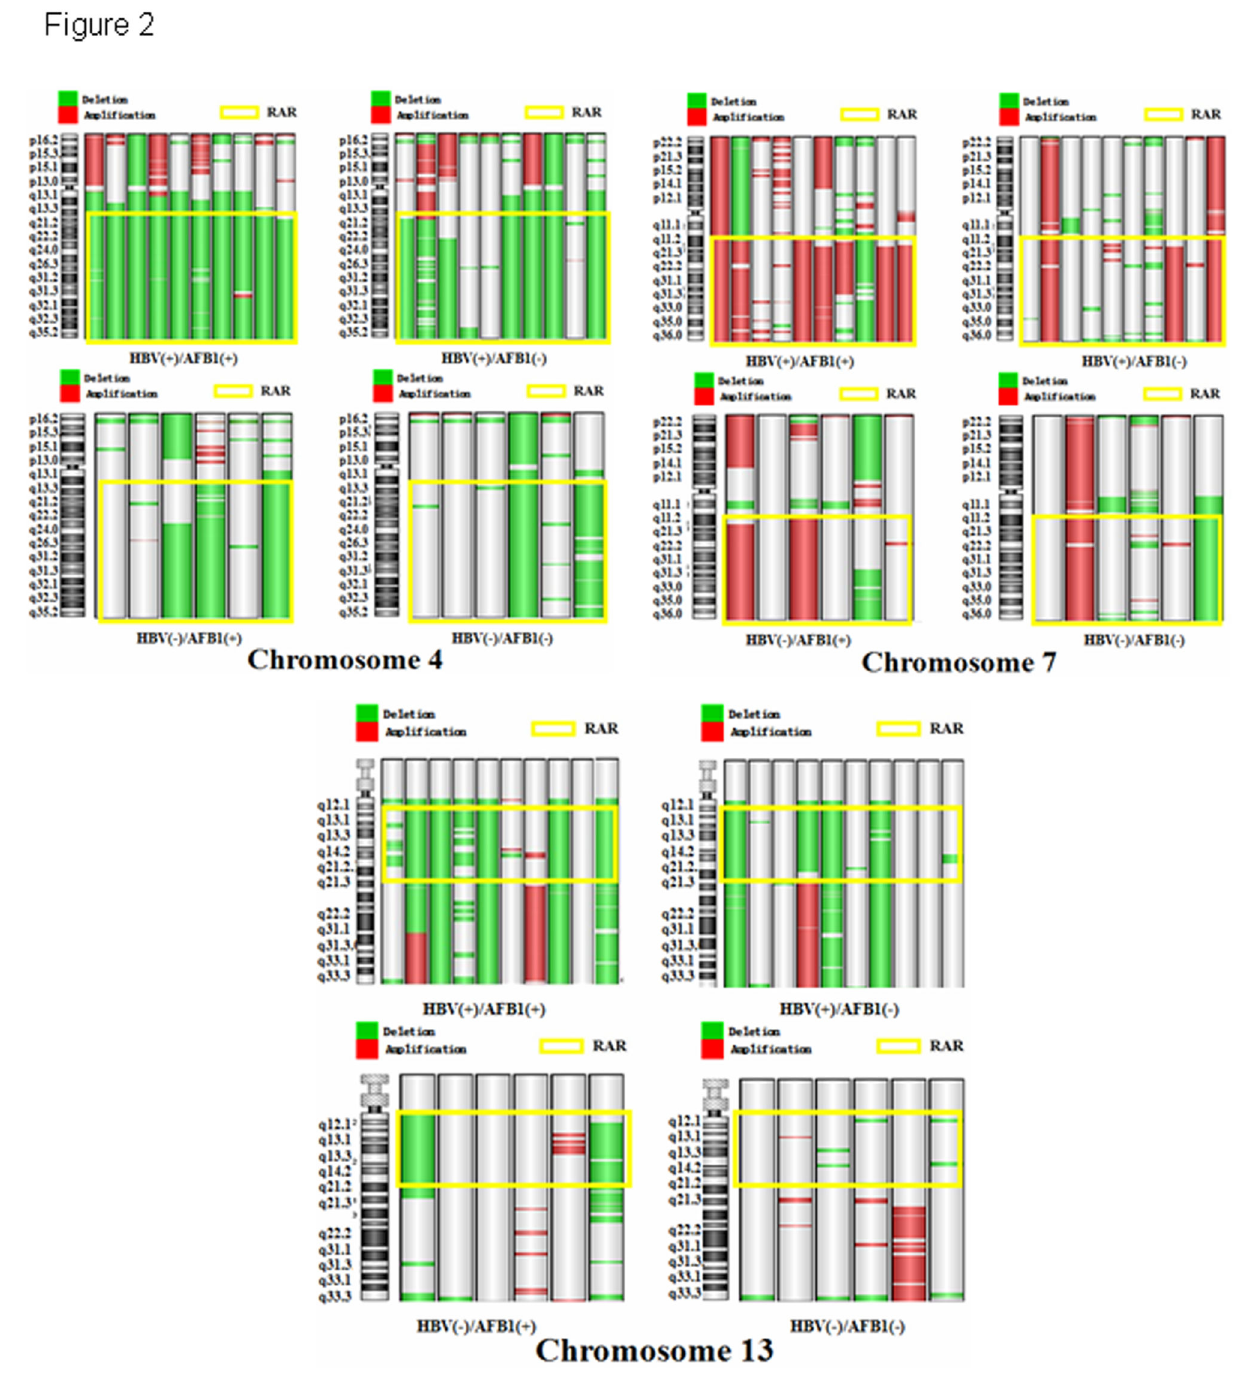
Figure 2. Representative comparison of incidence of RAR:4q12-q35.2、RAR:13q12.1-q21.1 and RAR:7q11.2-q35 in the 4 groups based on HBV and AFB1 status. (%). Red bar: the loss of chromosome; Green bar: the gain of chromosome. Yellow frame: Recurrently Altered Regions